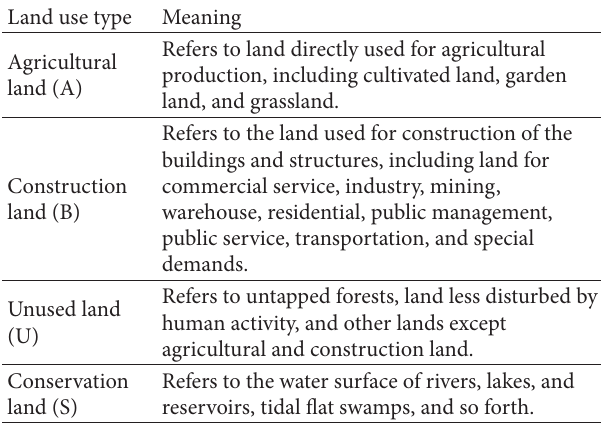
Table 2: Classification of land use types.